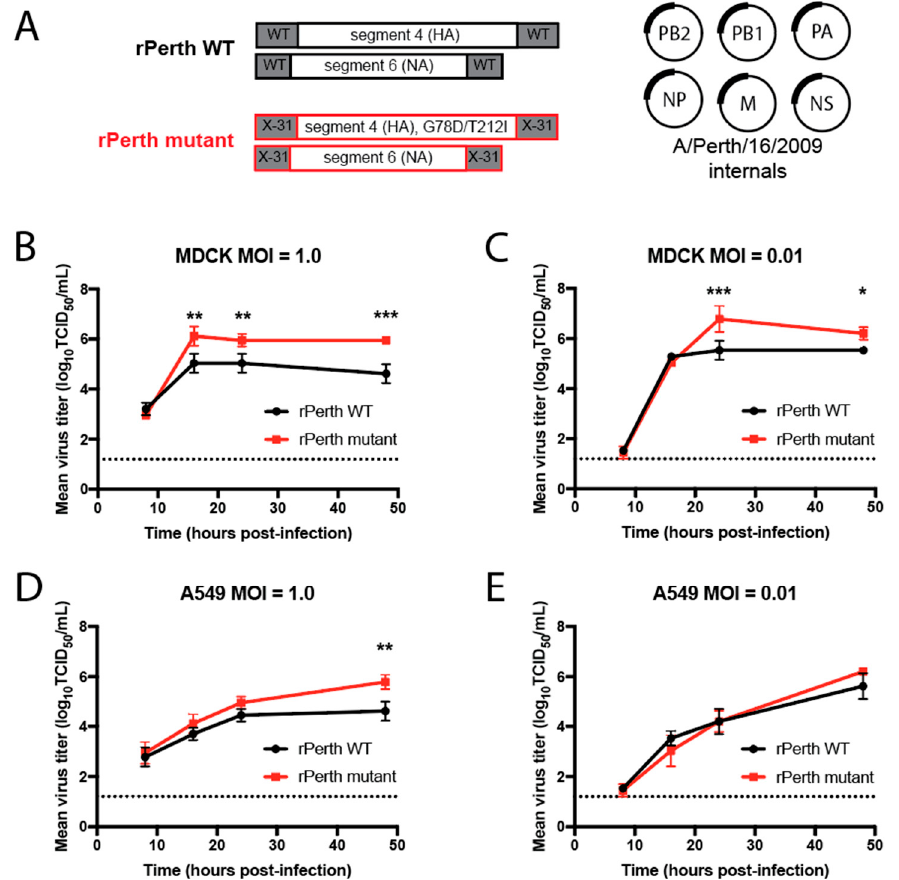
Figure 1. In vitro replication of cell-culture-adapted H3N2 virus. ( A ) Schematic representation of recombinant (r) A/Perth/16/2009 wild-type (WT) and mutant virus constructs. MDCK ( B , C ) and A549 ( D , E ) cells were infected with rPerth WT (black circles) and HA mutant (red squares) viruses at MOIs of 1.0 or 0.01. Cells were infected in triplicate and supernatants were collected at the indicated times. Virus titers were determined on MDCK cells using TCID 50 assays. Graphs are representative of three independent experiments. Two-way ANOVA was used to determine statistical significance (* p < 0.05, ** p < 0.005, *** p < 0.0005). The dashed line denotes the limit of detection for the titration assay.